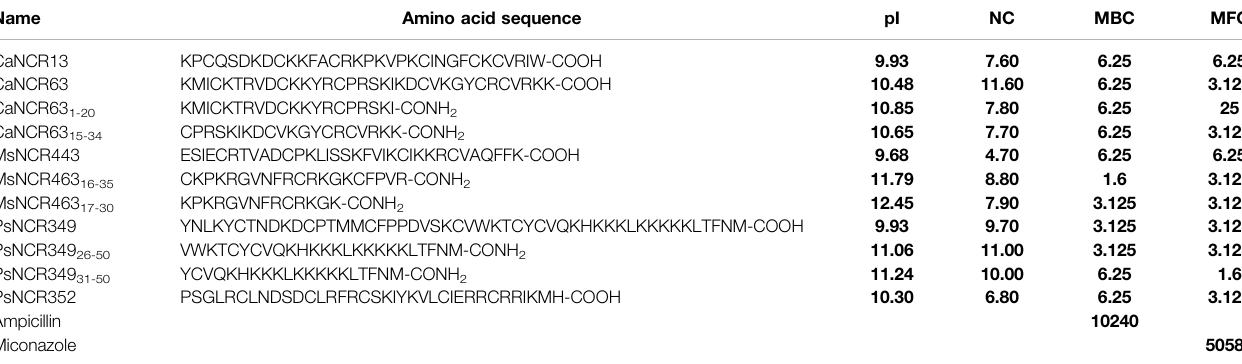
TABLE 1 | Antimicrobial activities of NCR peptides against A. baumannii and C. albicans